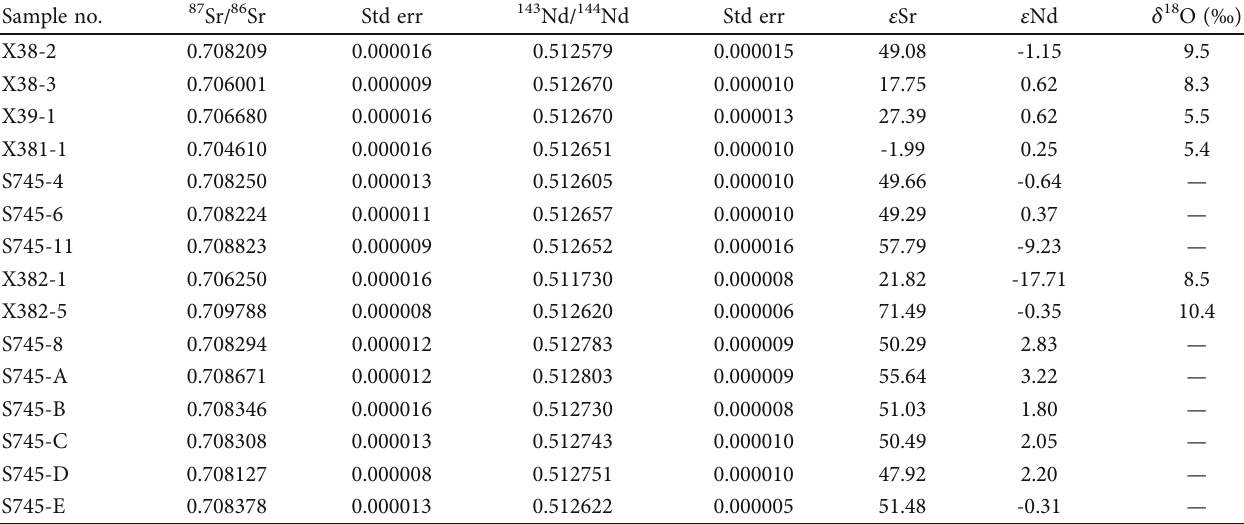
Table 3: Sr-Nd-O isotopic compositions of Paleogene igneous rocks in Huimin Sag. Sample no.